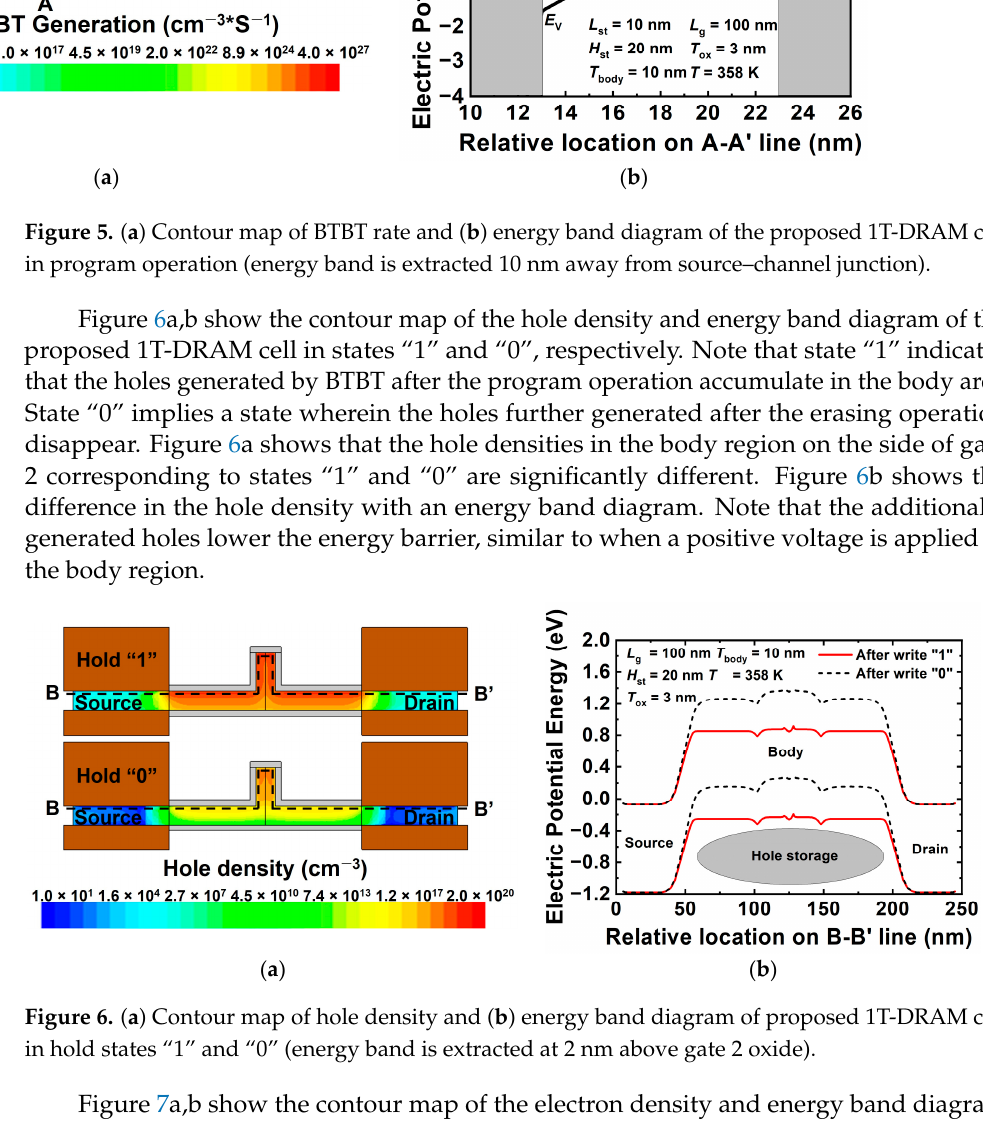
positive voltage is applied to the body region, and when read “1” is operated, the energy barrier in the body region is lowered and a high current flows. Because the current changes depending on the presence of excess holes, it is possible to distinguish between data “1” and “0”. The difference between read “1” current and read “0” current is defined as a sensing margin in 1T-DRAM. ( a ) ( b ) Figure 7. ( a ) Contour map of electron density and ( b ) energy band diagram of proposed 1T-DRAM cell in read states “1” and “0” (energy band is extracted at 3 nm above gate 1 oxide). Figure 8a shows the contour maps of the SRH recombination rate for the proposed 1T-DRAM with different L st in the hold state “1” operation. As shown in Figure 5a, BTBT vertically occurs between gates 1 and 2 in the body region during program operation. Moreover, in Figure 5a, the circular dotted line indicates the region where BTBT is generated, and as L st becomes longer, the area where BTBT occurs becomes smaller. Therefore, it can be seen from Figure 8a that as L st increases, the BTBT rate decreases and the SRH recombination rate decreases because fewer holes are generated. Furthermore, when L st is 70 nm, SRH recombination transforms into SRH generation at the source– channel and channel–drain junctions, and in Figure 8b, the current corresponding to read “1” increases with the hold time and becomes unstable. Therefore, for all the